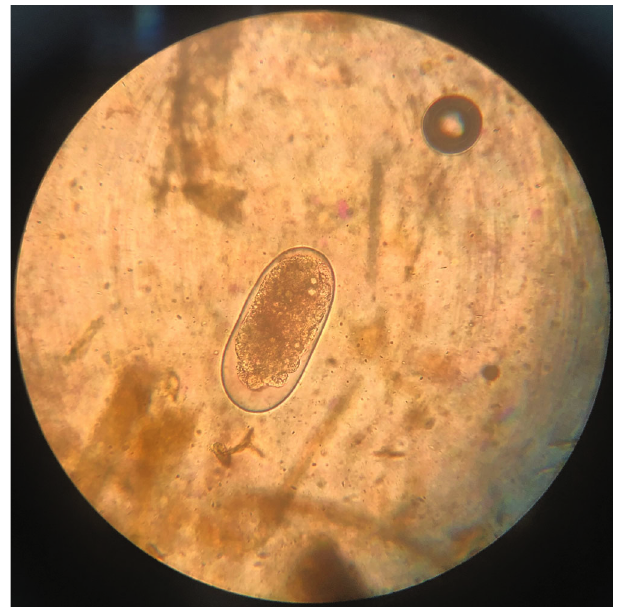
Figure 2: Oesophagostomum : the egg is ovoid, has a thin shell, measures 40 – 60 μ m × 70 – 100 μ m, and contains several cells, depending on the species.